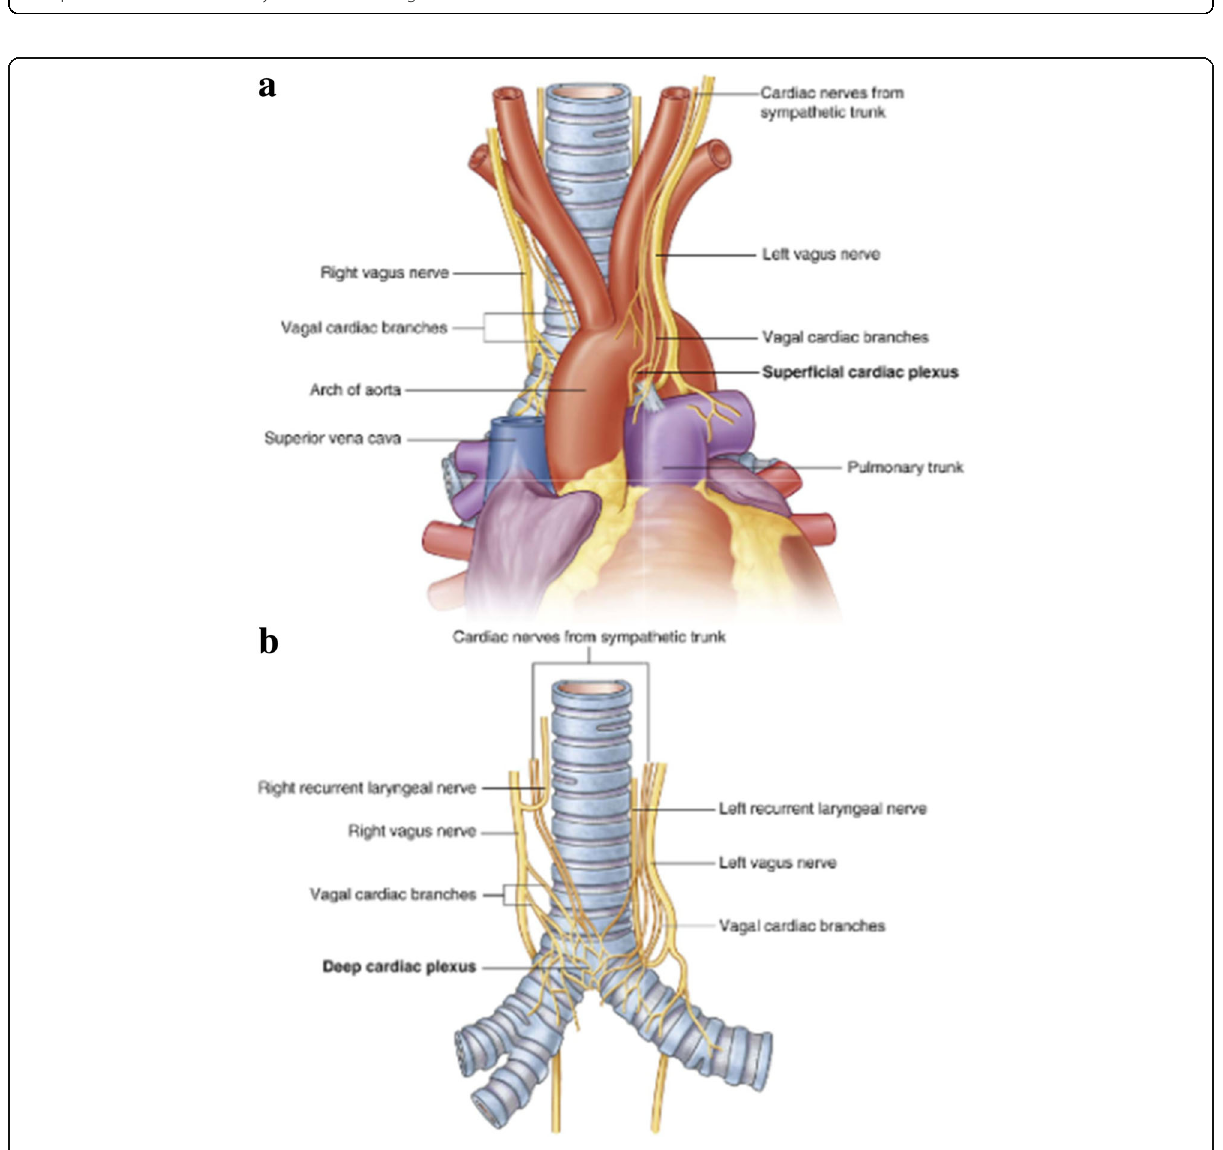
Fig. 3 The anatomy of cardiac plexus, showing the superficial part ( a ) and the deep part ( b ) [1]